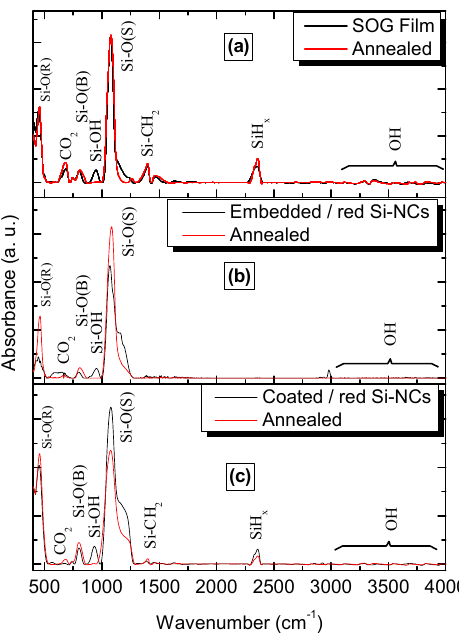
Figure 5. (Color Online) FTIR (Fourier transform infrared) spectra before and after annealing at 1100 °C for 3 h in N 2 atmosphere of pure SOG film ( a ); embedded ( b ); and coated ( c ) films fabricated with red Si ‐ NCs.